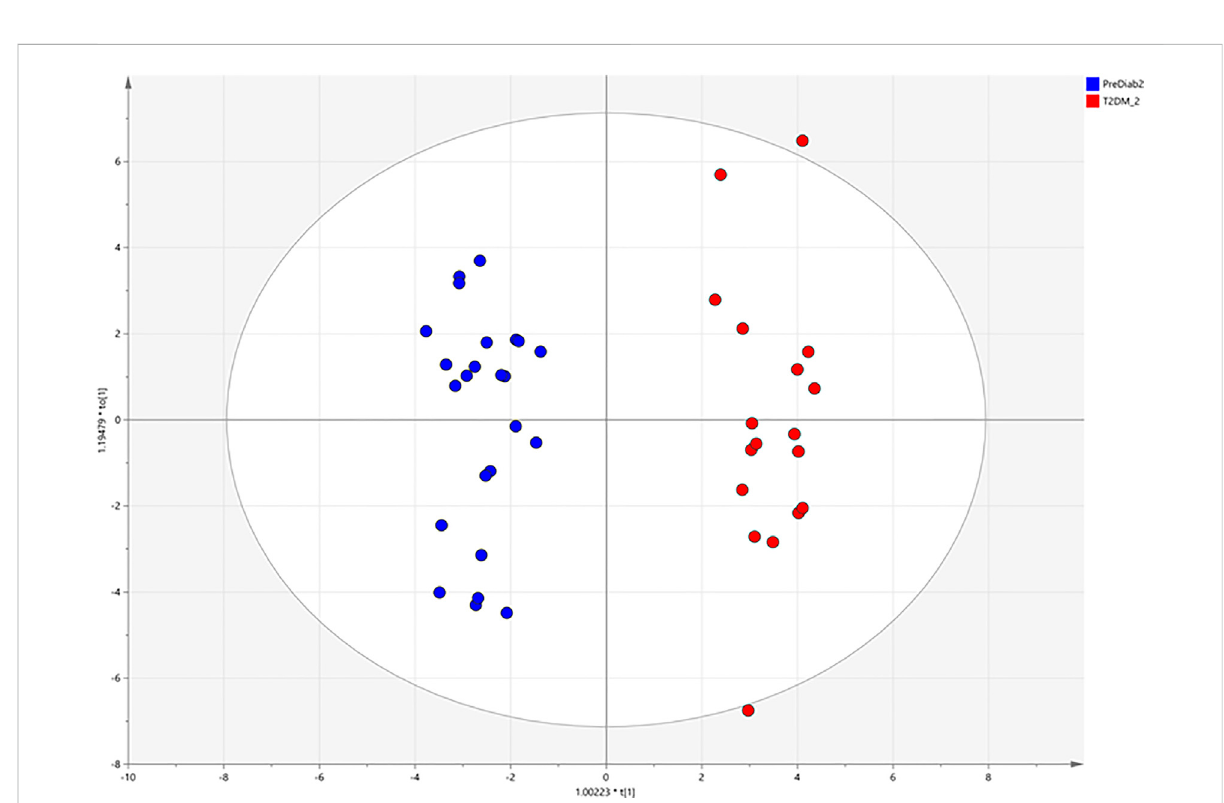
FIGURE 4 OPLS – DA score plots illustrating discrimination between the two studied groups based on obtained GC-MS data.